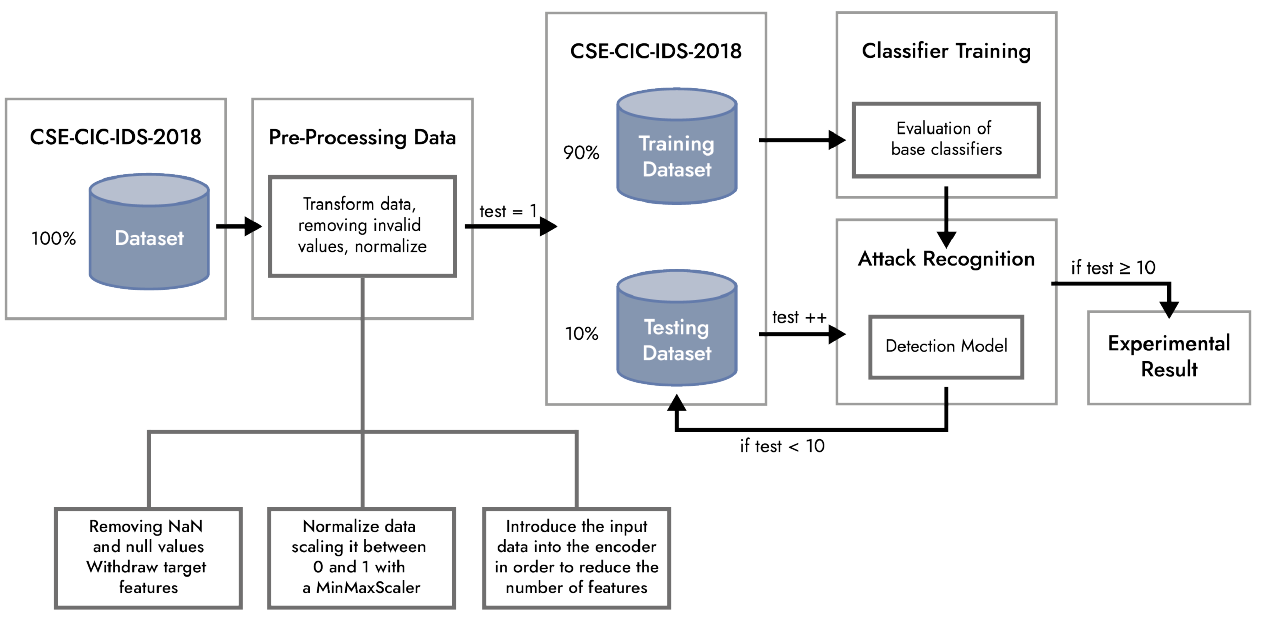
Figure 6. Overall processing